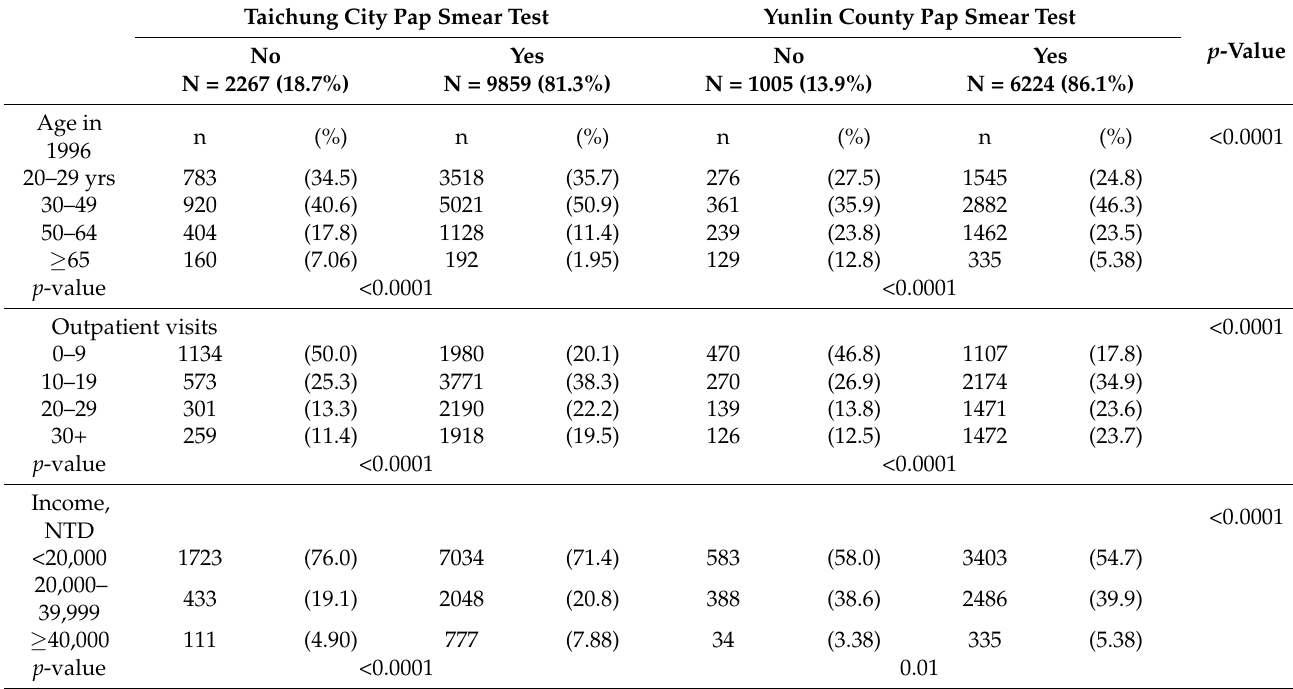
Table 1. Comparison between women who ever received and who never had Pap smear screening test by age, outpatient visits, and income among women in Taichung city and Yunlin